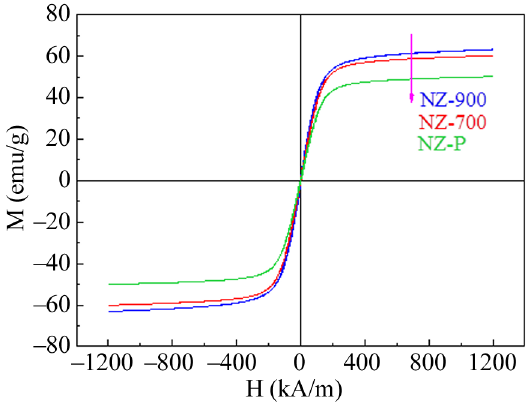
Figure 5. Magnetic hysteresis loops of specimens NZ-P, NZ-700 and NZ-900 at room temperature.